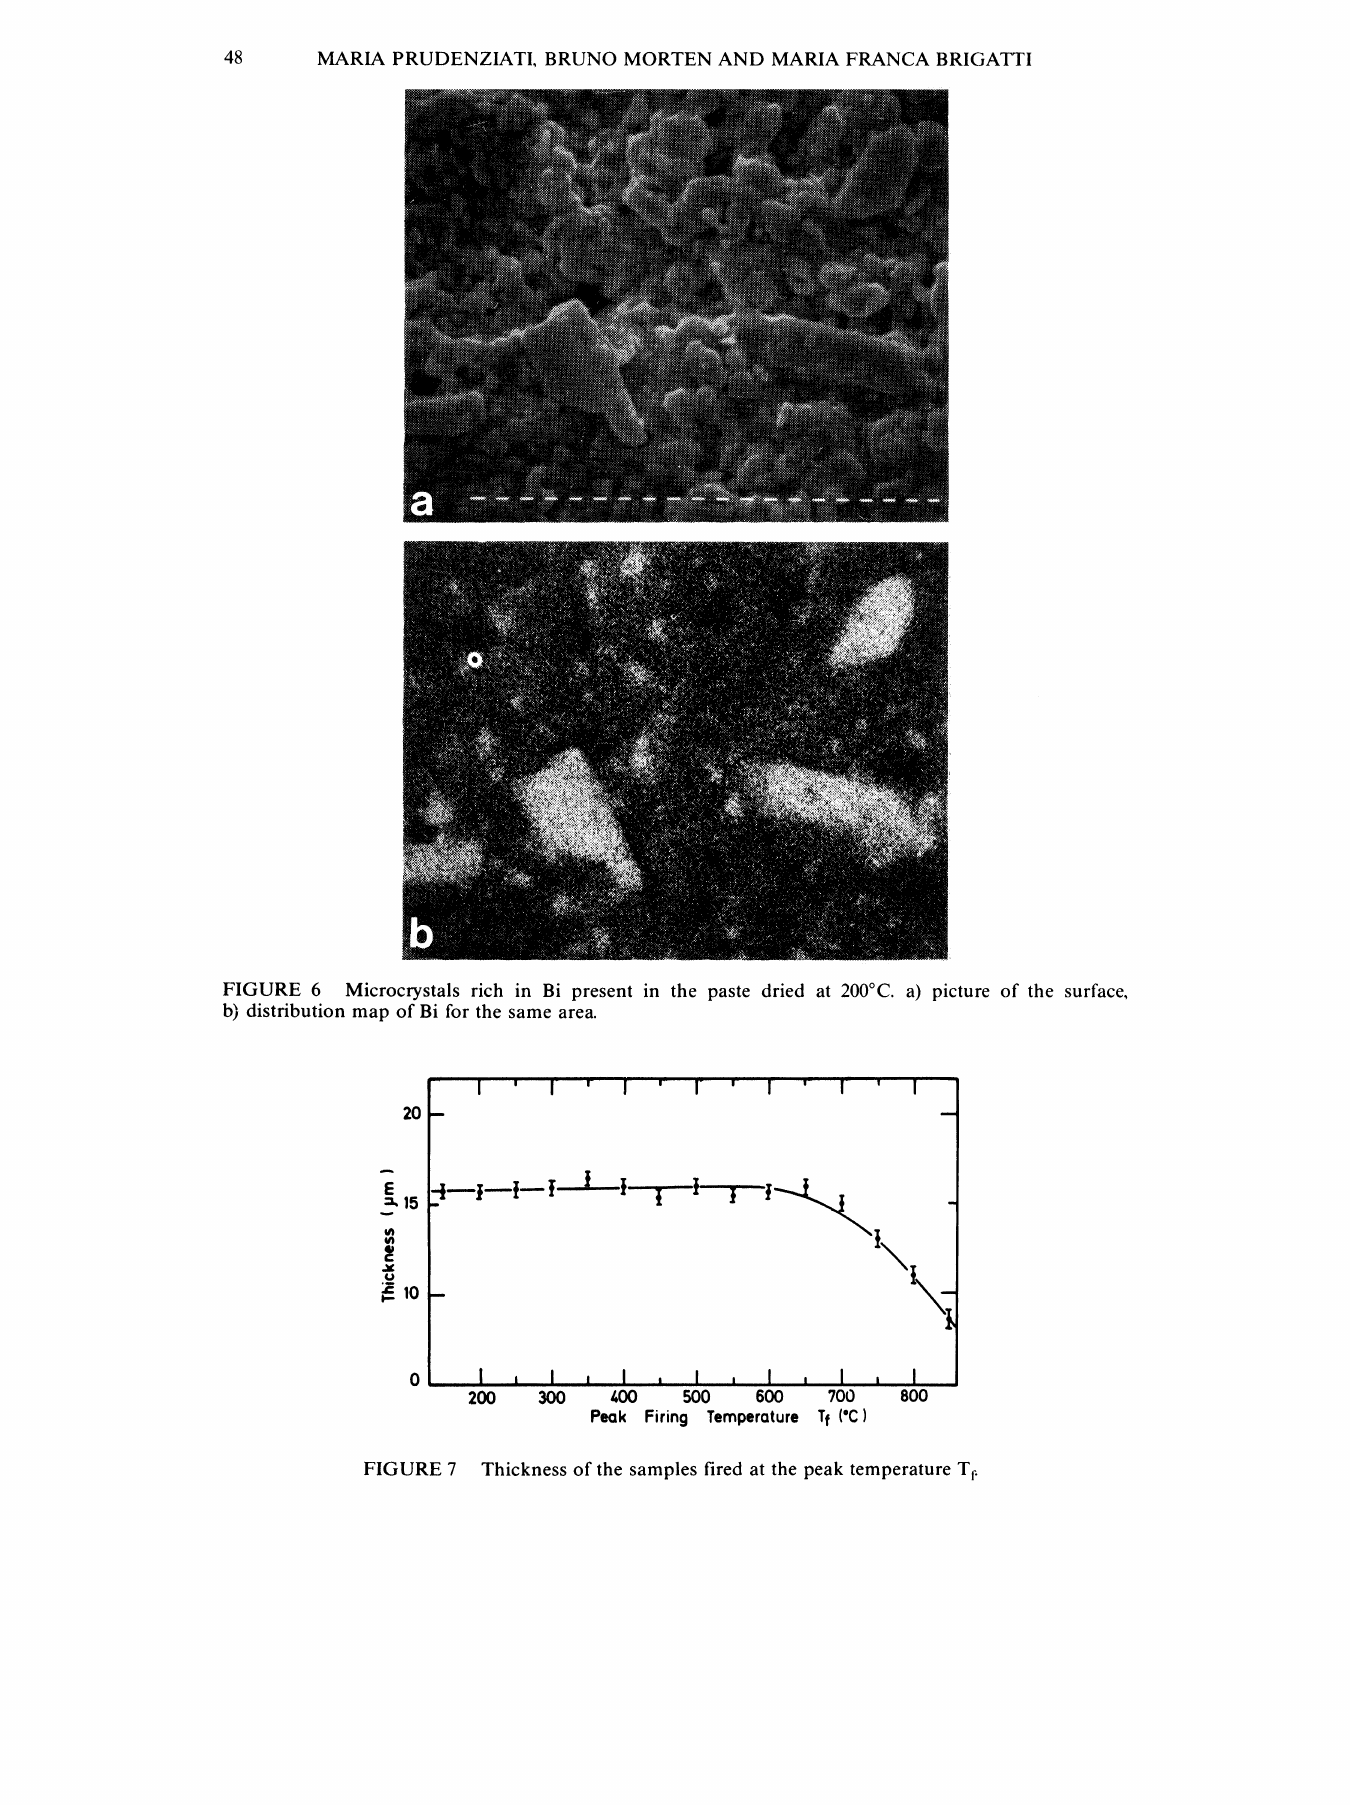
Microcrystals rich in Bi present in the paste dried at 200C. a) picture of the surface, b) distribution map of Bi for the same area.